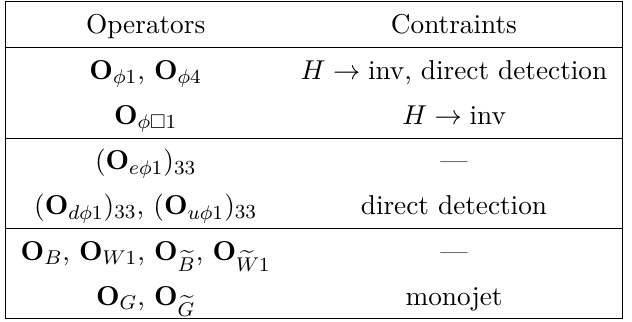
Table 1 . Allowed operators for a real scalar singlet DM candidate and sources of constraints over their coefficients. All operators are relevant for setting the correct DM abundance. They all have dimension 6, except for O , which has dimension φ 1